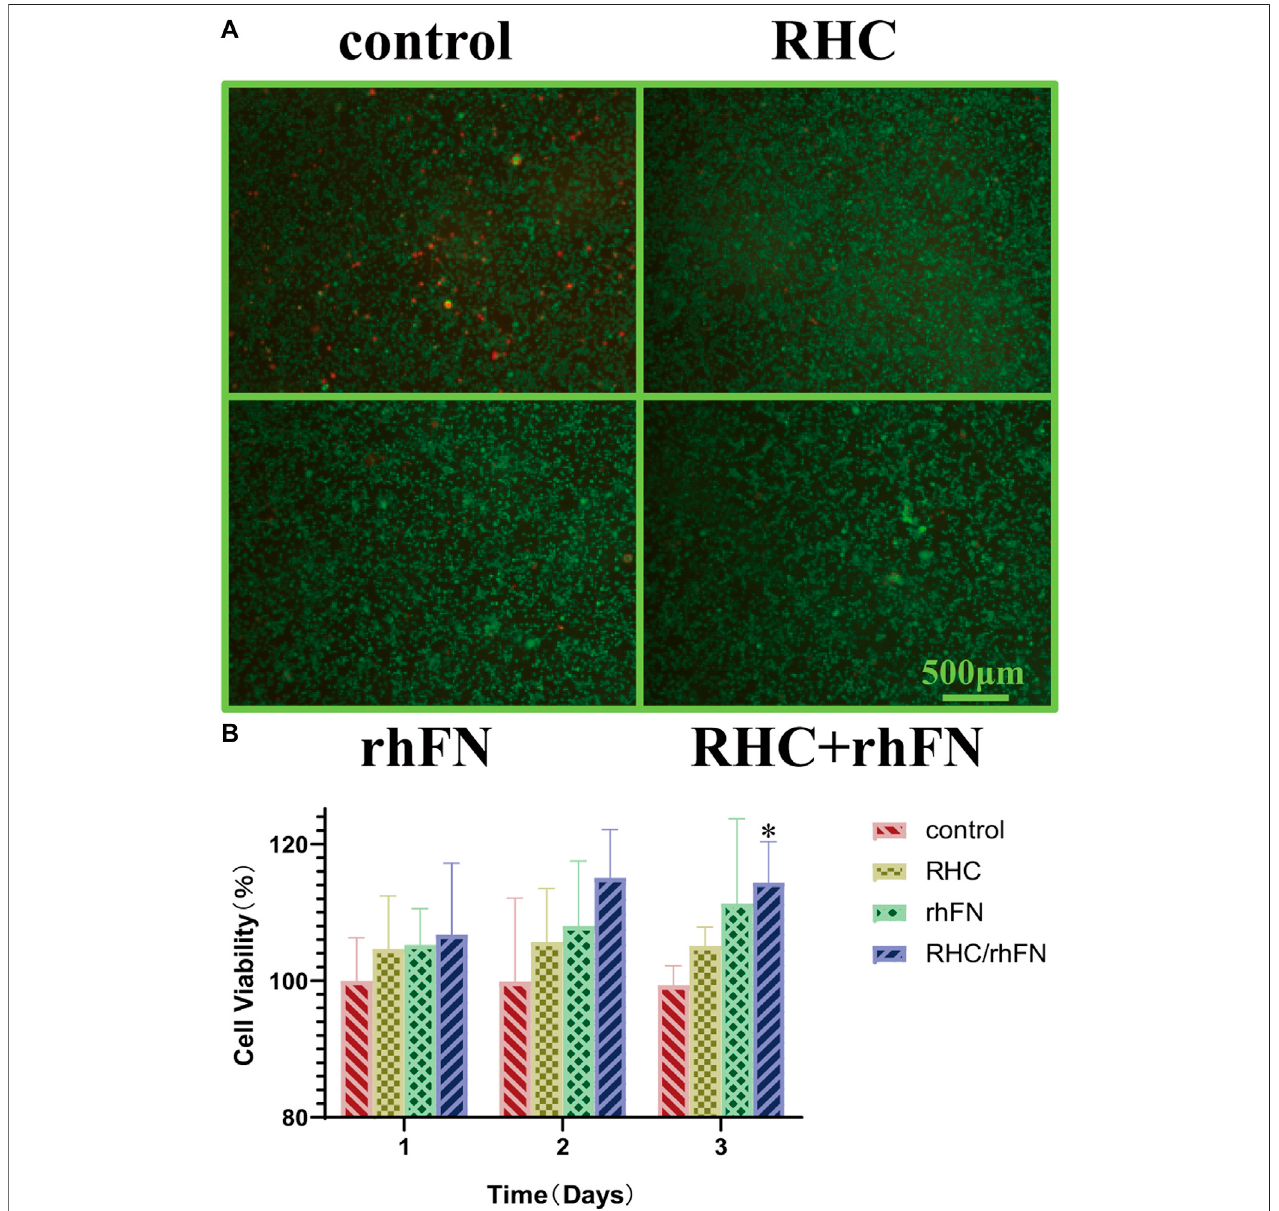
FIGURE 3 | The effect of RHC + rhFN on biocompatibility with FCs. (A) Live/Dead staining images of FCs at hour 24. Scale bar = 500 μ m (B) Calculation and comparison of cell viability on days 1,2 and 3. Data are presented as the mean ± SD ( n = 6). Statistical analysis: p p < 0.05.